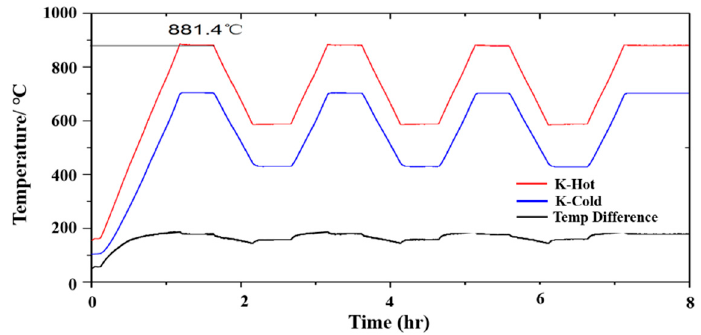
Figure 10. The hot junction temperature, clod junction temperature, and temperature difference during testing.